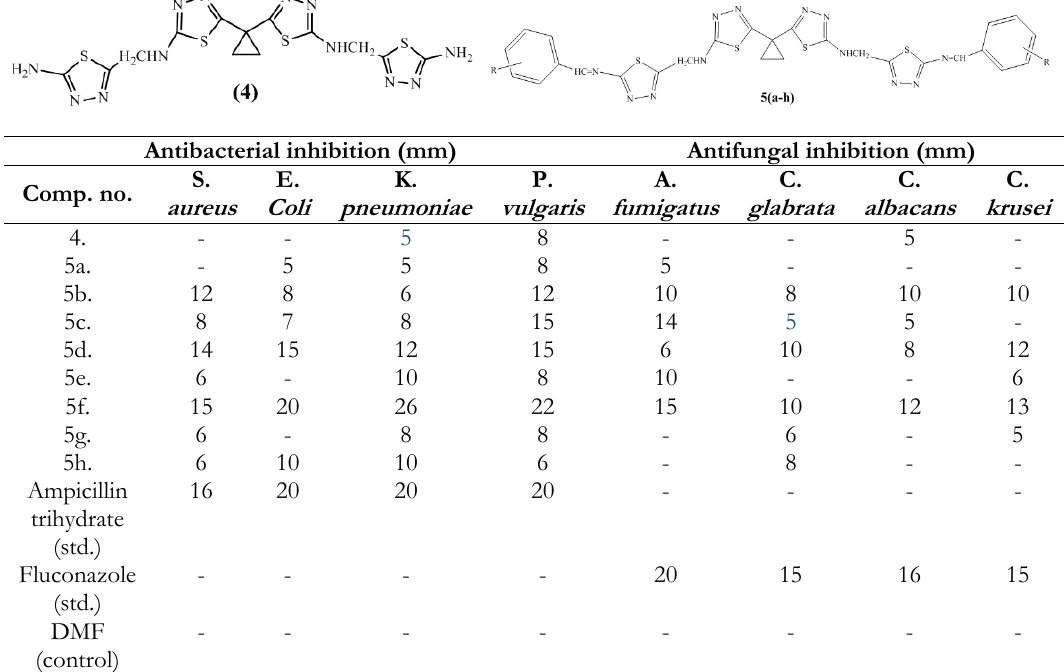
Antibacterial inhibition (mm) Antifungal inhibition (mm) Comp.